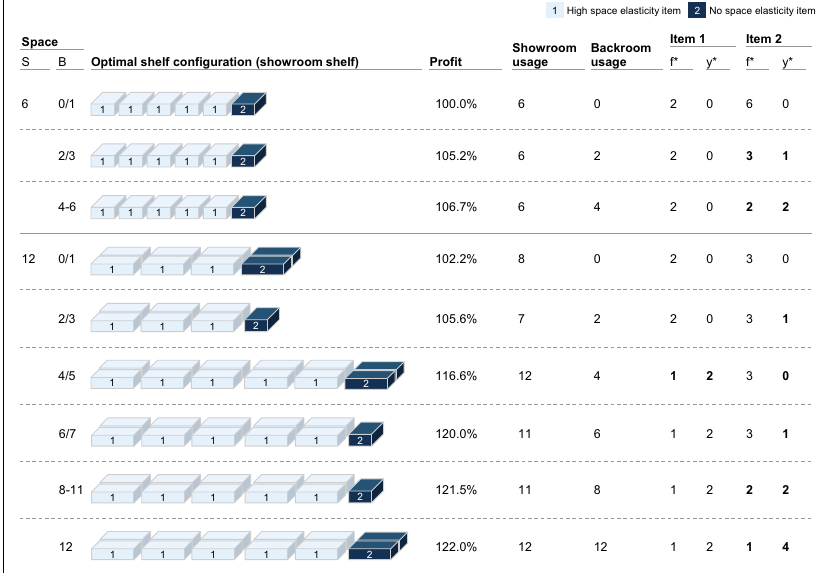
S B Optimal shelf configuration (showroom